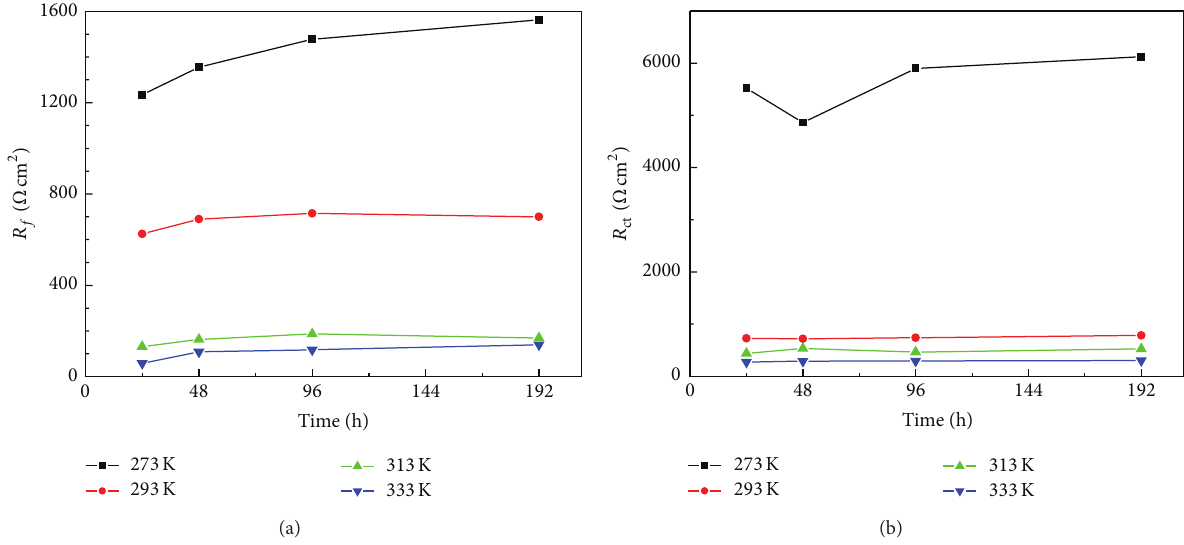
Figure 7: Changes of 𝑅 𝑓 (a) and 𝑅